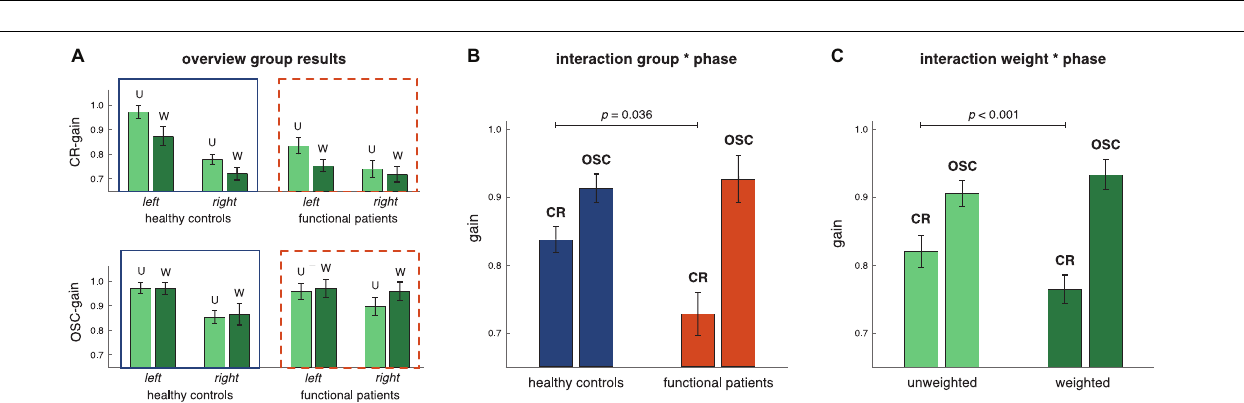
FIGURE 3 | Filtered raw data of experimental movement recordings with illustrated gain computation. (A–D left) Shown are representative eye (light) and head (dark) velocity traces of one typical healthy subject (A,B) and one typical functional patient (C,D) for the unweighted (natural, A,C ) and weighted condition (increased head inertia, B,D ). The dashed horizontal lines display the zero line. Head oscillations—and counteracting eye movements—are illustrated in the window with increased y-axis scale (note that the functional dizziness patient display more pronounced head oscillations than the healthy participant, even in the natural condition. Group analysis confirming these differences have been published in Lehnen et al., 2019). (A–D right) Shown is eye velocity plotted against head velocity (gray circles) for counter-rotation (CR) and oscillation (OSC) gain computation for one representative gaze shift. Gaze gains are displayed as the slope of the solid lines, which represent the linear regression of eye velocity in head depending on head velocity in space. Perfect gaze stabilization, i.e., a gaze gain of 1, is indicated by the dashed line. The healthy subject shows intact CR-gaze stabilization in the unweighted condition, which is reduced by increasing the head inertia in the weighted condition. The functional patient displays reduced CR-gaze stabilization in the unweighted condition, which is further reduced in the weighted condition. During OSC epoch, both the healthy subject and the functional patient show intact gaze stabilization.